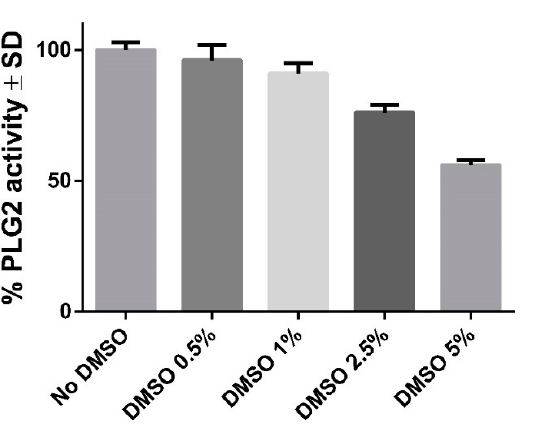
Figure 2. PLG2 luminescence emission in the presence of varying concentrations from 0.5 to 5% of DMSO. Error bars represent mean ± SD.